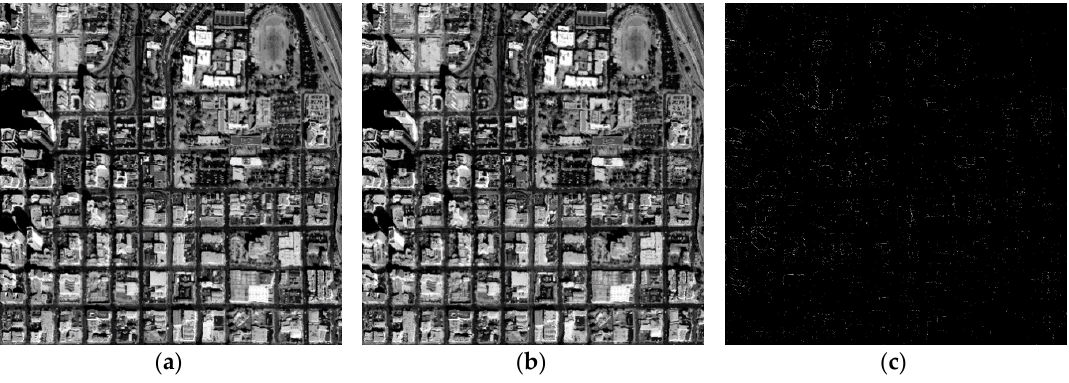
Figure 15. Orthoimages for the first study area: ( a ) by FPGA; and ( b ) by Matlab; and ( c ) the difference of image ( a ) and image ( b ).